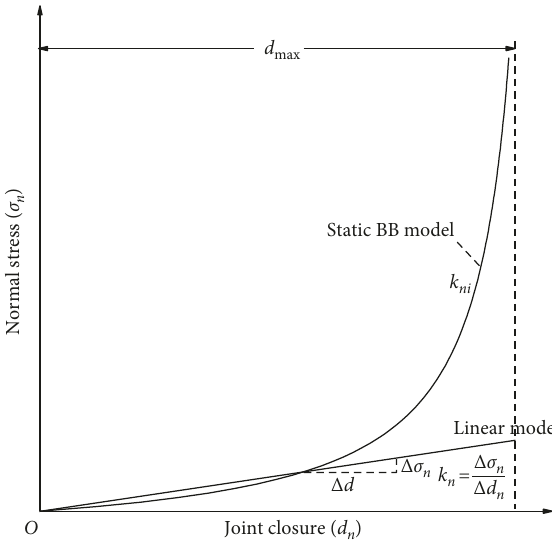
Figure 3: Schematic of the static BB model for a rock